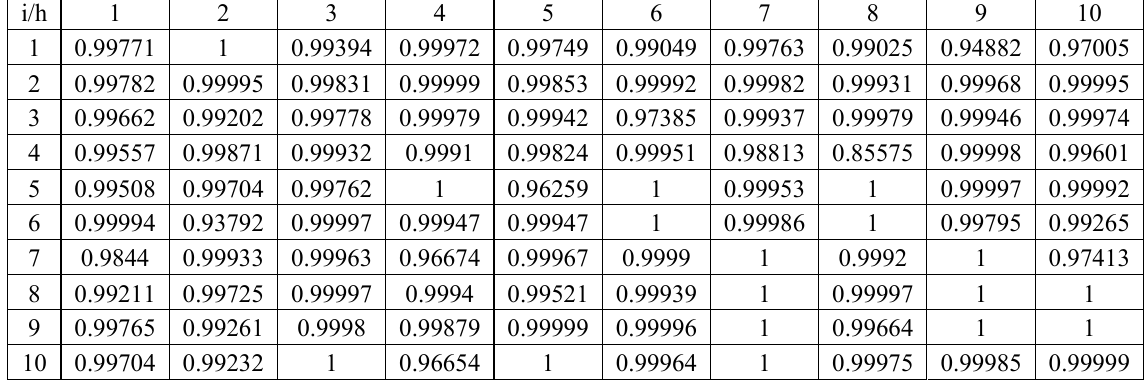
Table 1. BPNN topology regression performance (i = nodes in the input layer, h = nodes in the hidden